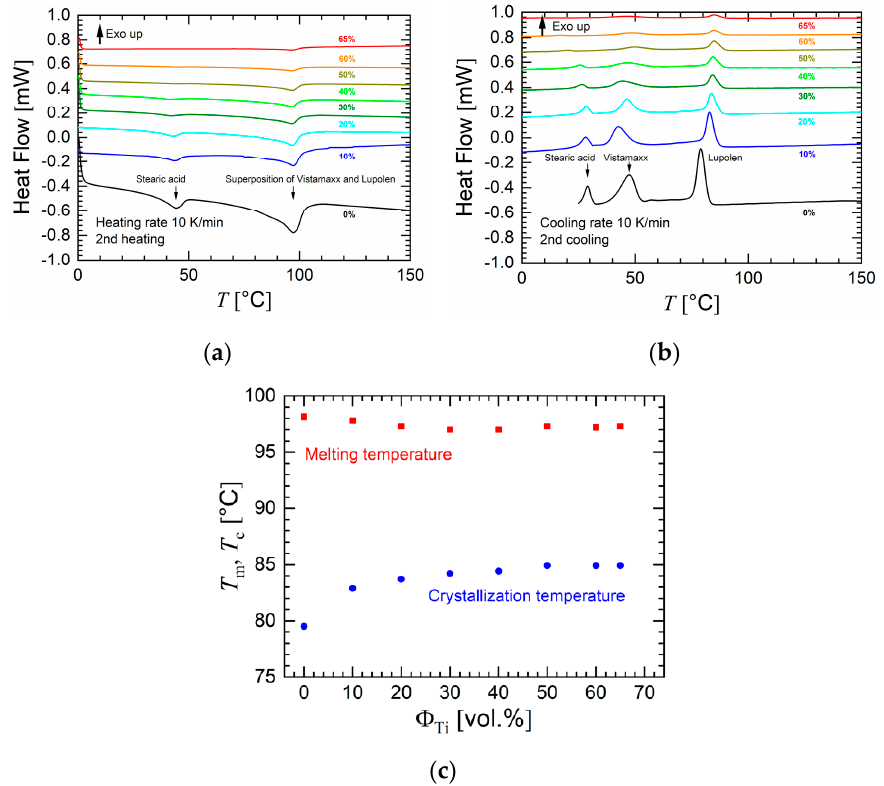
Figure 7. Results of di ff erential scanning calorimetry investigations in nitrogen atmosphere. The heating and cooling rates were 10 K / min. ( a ) Second heating interval. ( b ) First cooling interval. ( c ) Highest melting and crystallization temperatures ( T m , T c ) as a function of metal concentration. The data in ( a , b ) were shifted for